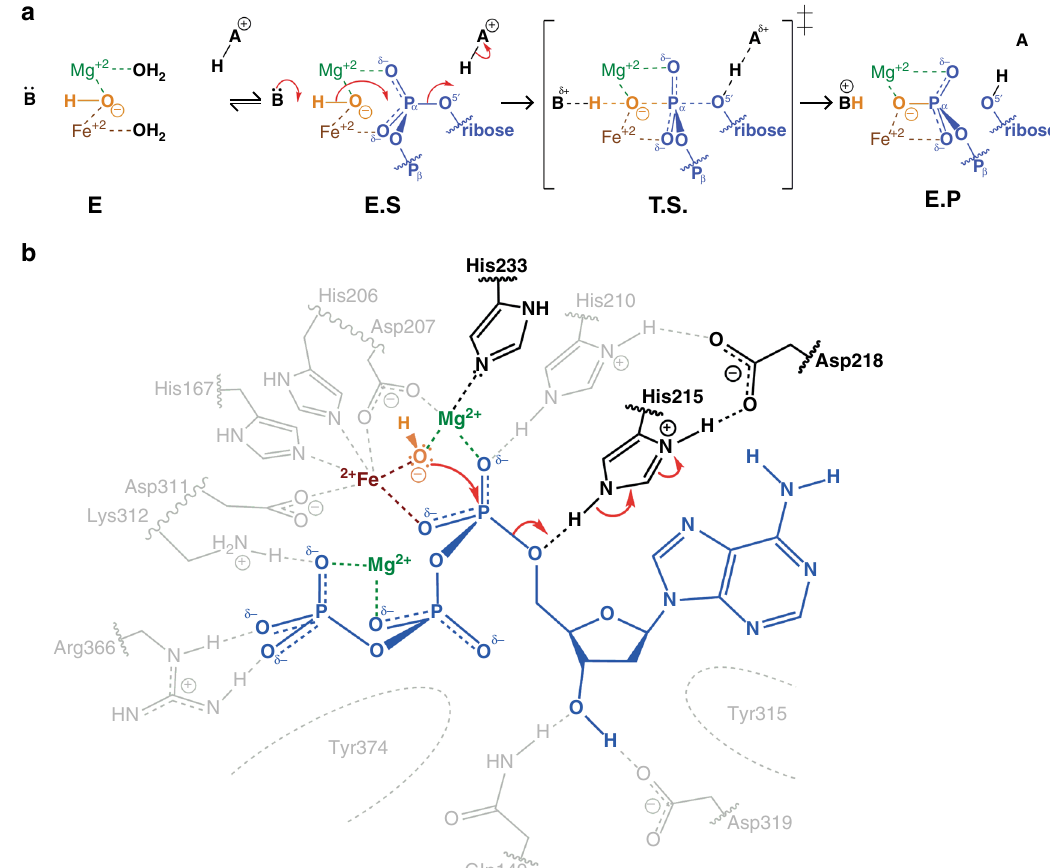
Fig. 5 Catalytic mechanism of SAMHD1-dNTP hydrolysis. a Schematic of the chemical mechanism of SAMHD1-dNTP hydrolysis. In the apo state (E) the W0 water molecule (orange) is coordinated between the HD motif-bound Fe ion and by Mg3, further water molecules take up the remaining coordination positions on the metal ions. On substrate binding, the enzyme – substrate complex (E.S) is formed and P α oxygens replace water molecules to coordinate the Mg3 and Fe ions and also position the W0 nucleophile in line with the electron de fi cient α -phosphate. The reaction proceeds by adduction of the W0 nucleophile to the α -phosphate to form a trigonal-bipyramidal intermediate transition state (T.S.). The resulting accumulating negative charge is relieved by protonation of the leaving nucleoside 5 ′ oxygen to form the enzyme product complex (E.P). b Schematic of SAMHD1-active site conformation during the hydrolysis reaction. A bound substrate dATP nucleotide is shown in blue, W0 in orange, the HD Fe ion in brown and active site Mg ions in green. The side chains of His233 and His215 and Asp218 required for catalysis are highlighted and the direction of electron transfer is indicated by the red